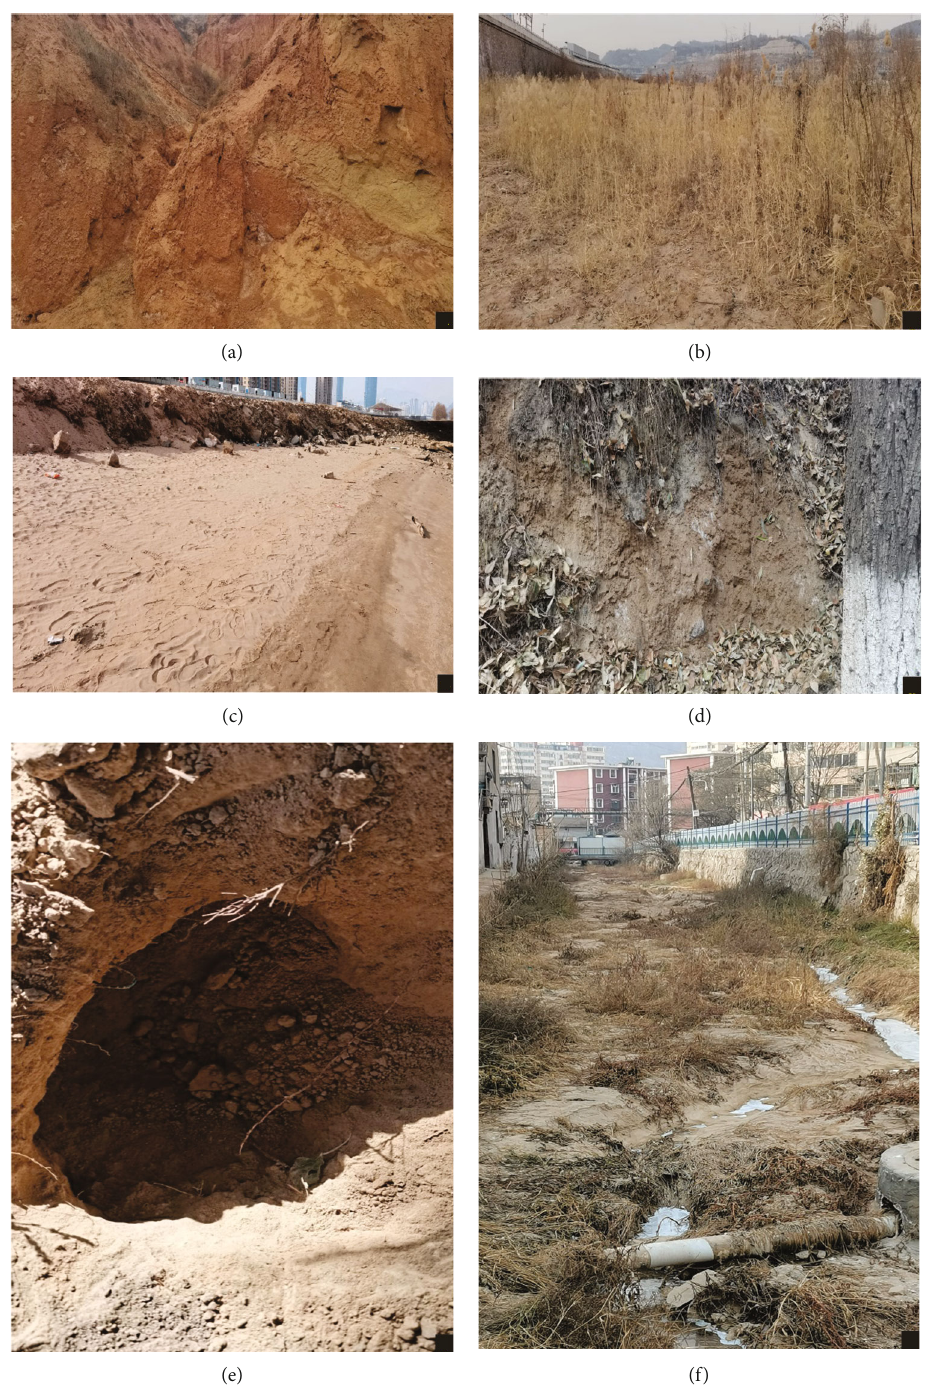
Figure 2: Representative photos of sampling sites in Lanzhou city. (a) Pro fi le of mountain sediment from HSG, (b) pro fi le of wetland from HYRY, (c) pro fi le of river sediment from QBSQ, (d) pro fi le of mountain sediment from WQSE, (e) pro fi le of farmland from FJQ, and (f) pro fi le of marsh from